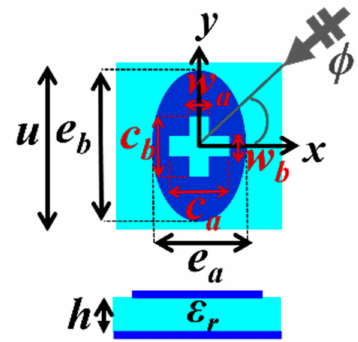
Figure 2. Unit cell geometry composed by a metallic elliptical patch with asymmetric cross-shaped aperture in the center, printed on a grounded substrate. Dimension u = 3.14 mm, AD-1000 dielectric with relative permittivity ε r = 10.2 and thickness h = 1.27